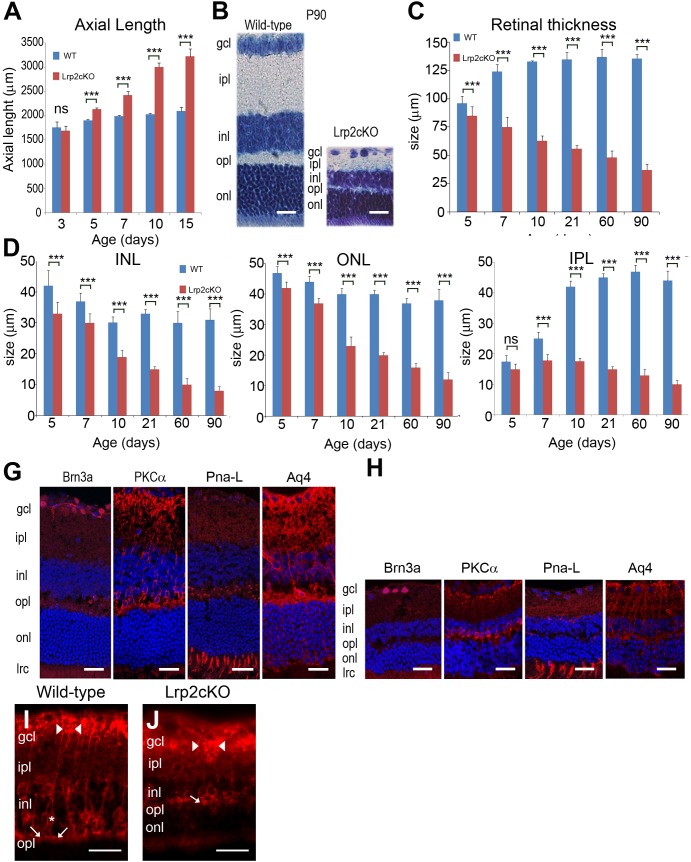
Histological and immunomorphological analysis of post-natal eye growth.Significantly increased axial length is first observed at P5 (A). The retinal lamination in P90 Lrp2
FoxG1.cre-KO mutant eyes is normal but all the retinal cell layers appear reduced; Nissl staining (B). The continuous reduction of the retinal thickness between P5 and P90 (C) is mainly due to the thinning of the inner nuclear (INL), outer nuclear (ONL) and inner plexiform (IPL) cell layers (D-F). The distribution of the typical retinal markers Brn3a, PKCalpha, PNA-Lectin (PNA-L) and Aquaporin 4 (Aq4) in the retinal ganglion, bipolar, photoreceptor and Müller cells respectively is similar in control (G) and mutant littermates (H). The number of PKCalpha, PNA-L and Aq4 positive cells appears decreased in the mutants. (I) PKCalpha immunoreactivity in bipolar cells shows a tight cluster of dendrites (arrow) in the OPL, an oval cell body (asterisk) in the INL, and a vertically directed axon, which expands into clusters of terminals (arrowheads) in the proximal portion of the IPL and GCL. (J) In the Lrp2
FoxG1.cre-KO mutant the PKCalpha positive bipolar cell has shrunk dendrites at the OPL-INL border (arrow) and a vertically directed axon, which expands abnormally in thick clusters (arrowheads) in the IPL and GCL. Two-way ANOVA post hoc Tukey test was used, **P<0.01, ***P<0.001, values are mean ± SEM of 10 animals per age and genotype. Scale bars: 50 μm in B, G, H; 70 μm in I, J.